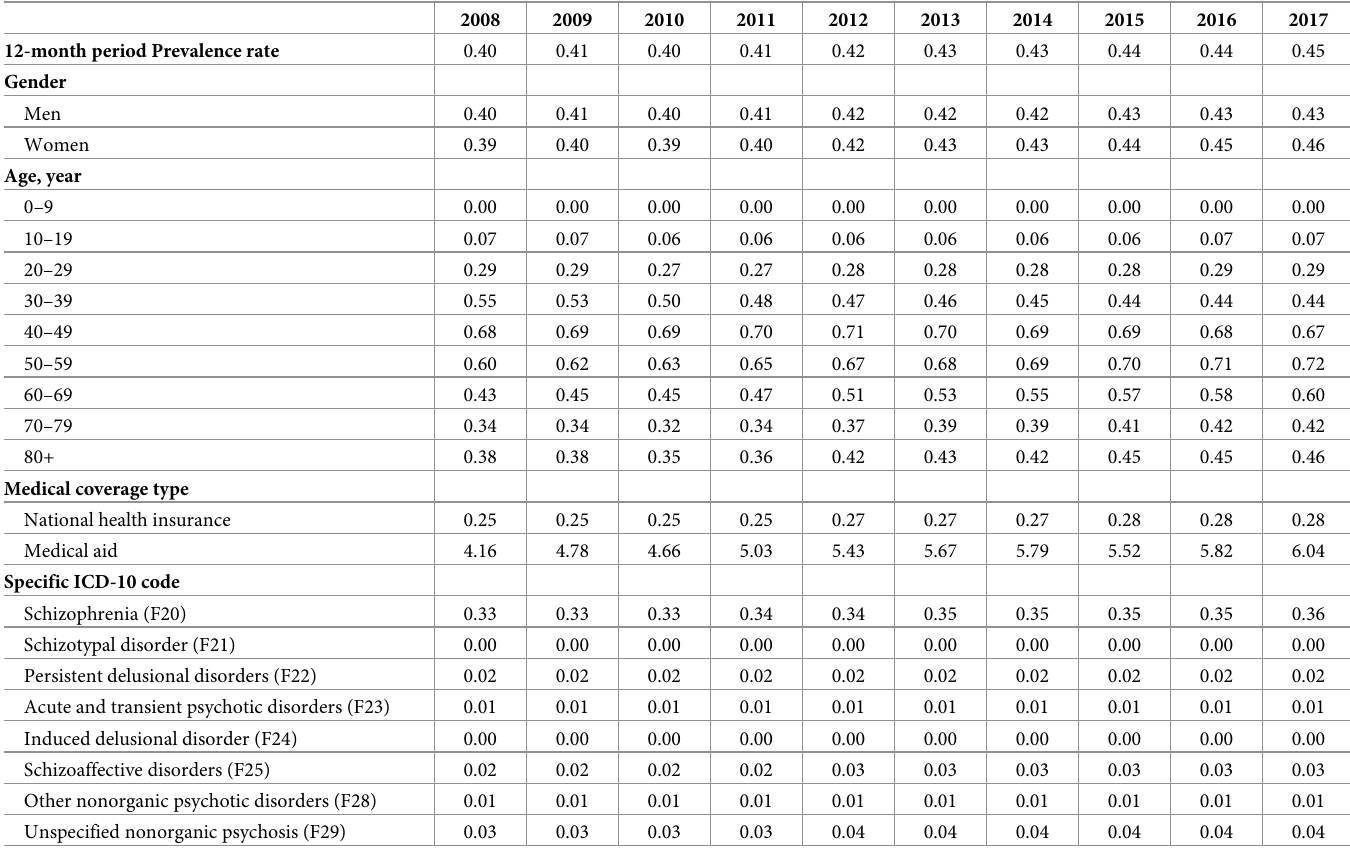
Table 1. 12-month prevalence rate of schizophrenia, schizotypal and delusional disorders, 2008–2017.